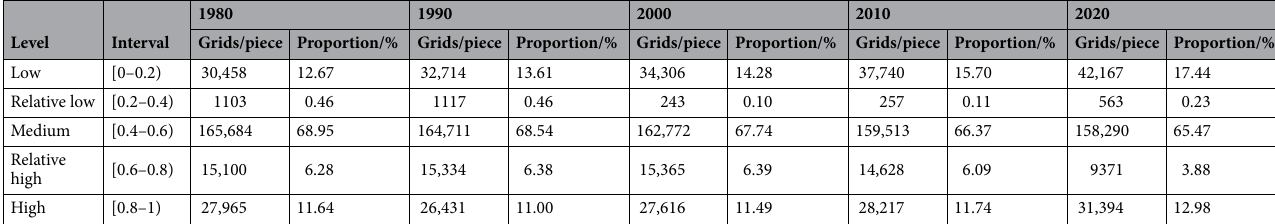
Table 4. The proportion of habitat quality level at different periods in Shandong